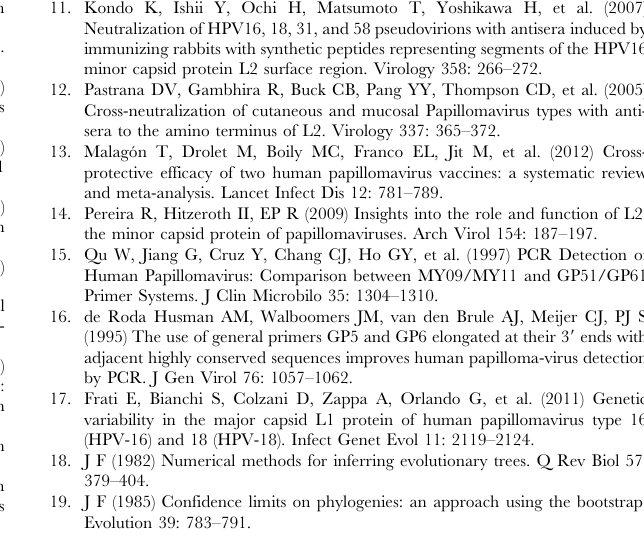
Table 6,7,8,9: lnL, the log-likelihood difference between the two models; 2 D l, twice the log-likelihood difference between the two models; The positively selected sites were identified with posterior probability $ 0.9 using Bayes empirical Bayes (BEB) approach. One asterisk indicates posterior probability $ 0.95, and two asterisks indicate posterior probability $ 0.99. NA means not allowed. NS means the sites under positive selection but not reaching the significance level of 0.9.